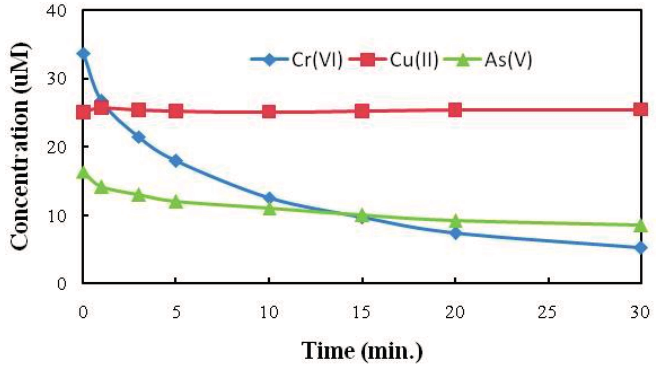
Figure 7. TiO 2 photocatalysis of Cr(VI) in presence of As(V) and Cu(II). [Cr(VI)] = 40 µM,